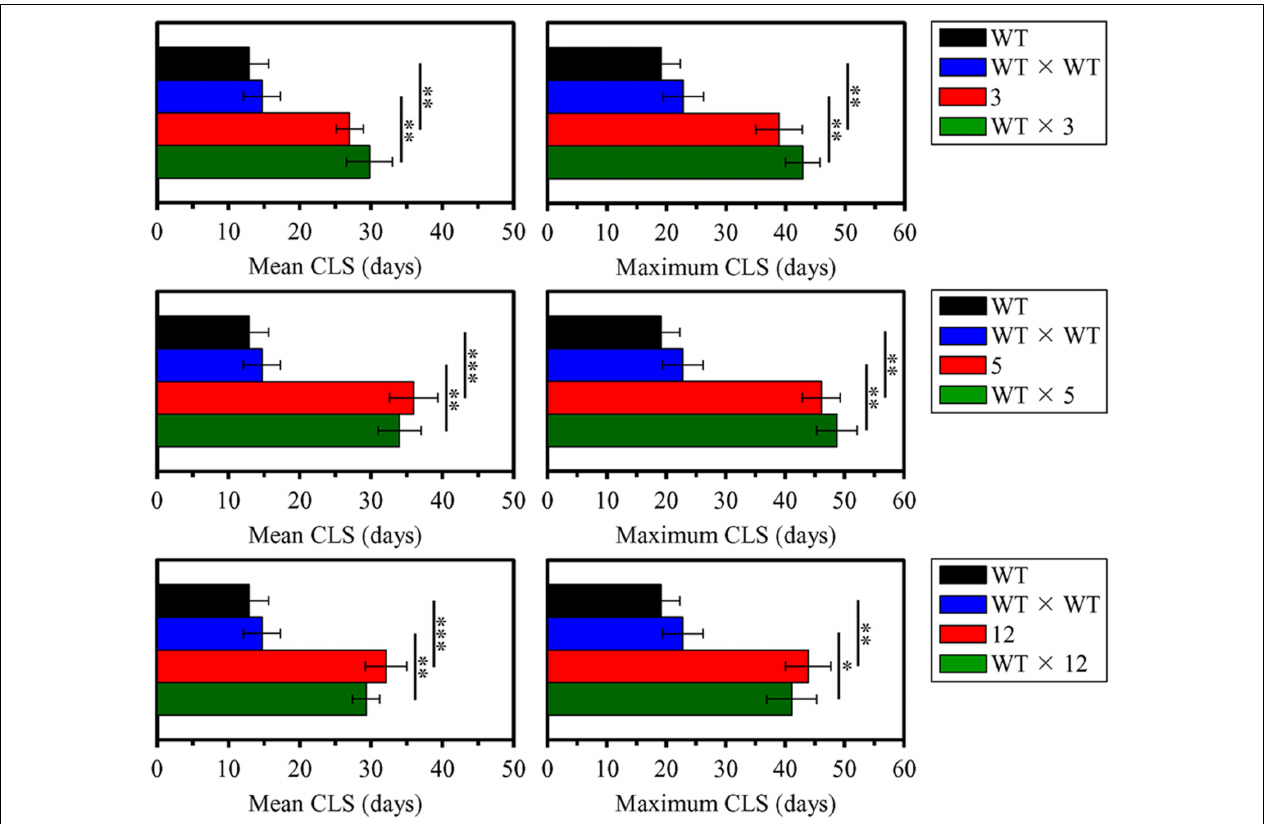
FIGURE 6 | The extended longevity of each of the three long-lived yeast mutants evolved under laboratory conditions is a dominant genetic trait. The parental haploid WT strain BY4742, the WT × WT diploid strain formed by mating between the haploid WT strains BY4741 and BY4742, the long-lived mutant strains 3, 5, and 12 (each in the BY4742 genetic background), and the WT × 3, WT × 5, and WT × 12 diploid strains were cultured in YP medium without LCA initially containing 0.2% glucose. Survival curves shown in Figure 7 were used to calculate the mean and maximum chronological lifespans for WT and mutant strains. Data are presented as means ± SEM ( n = 4; ∗ p < 0.05; ∗∗ p < 0.01; ∗∗∗ p <